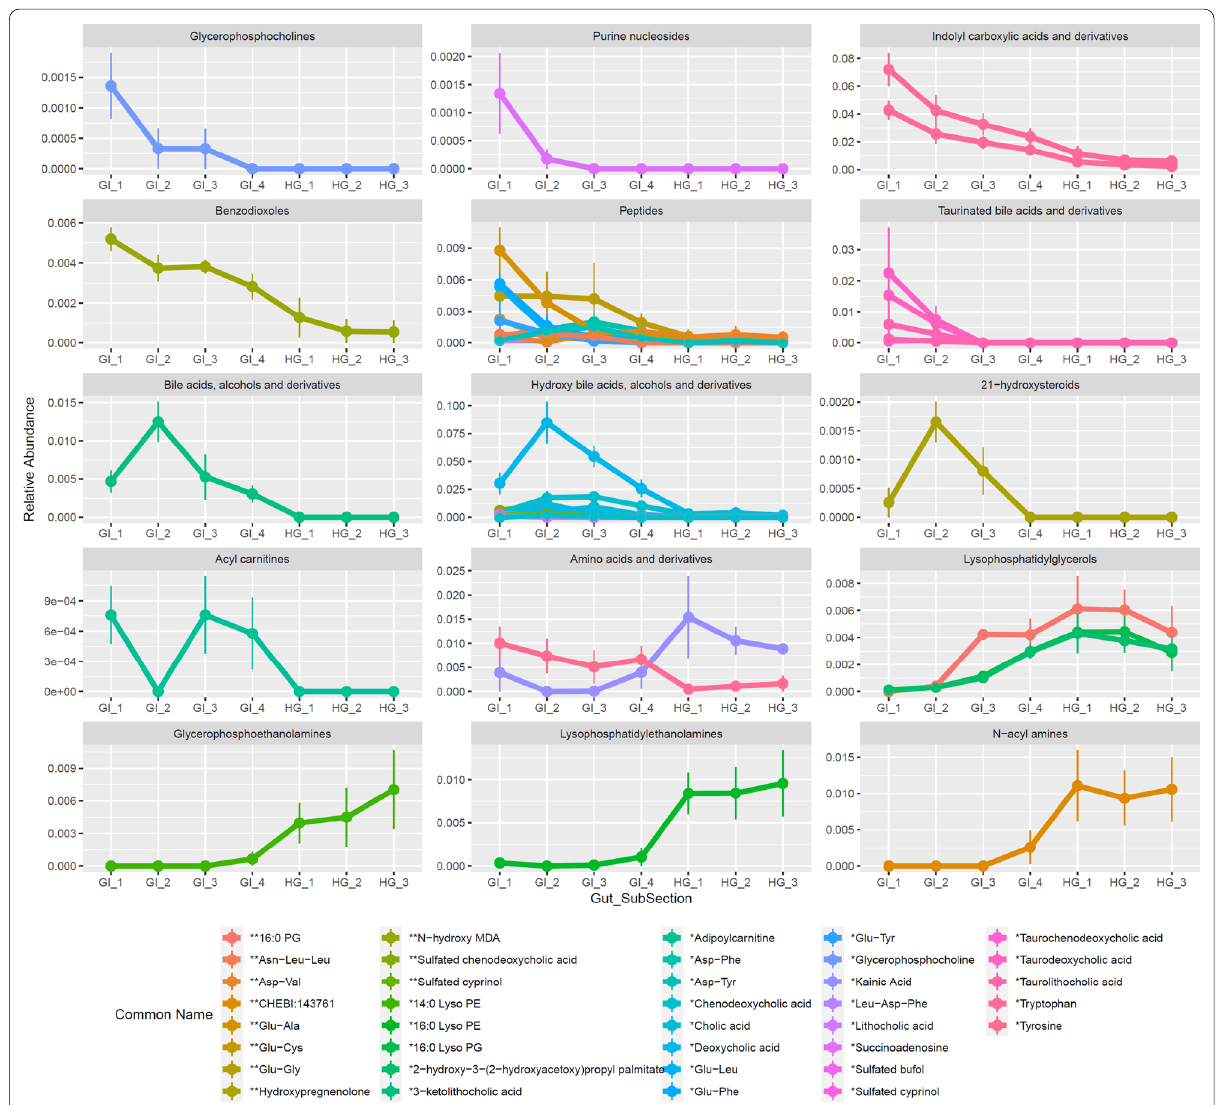
Fig. 7 ClassyFire Parent Level 1 trends across the Nenue gut in the 44 most abundant metabolites that responded significantly to gut subsection (adjusted p-value .05) and had known library or analog IDs. Average metabolite relative abundance is plotted against gut subsection, with plots ≥ separated by ClassyFire Parent Level 1, metabolites colored by library and/or analog ID, and vertical lines indicating standard error. Metabolites are labeled by their common library and/or analog ID, with one asterisks indicating a match class level 2 (library ID) and two asterisks indicating a match class level 3 (analog ID). Plots are ordered by gut subsection enrichment from anterior to